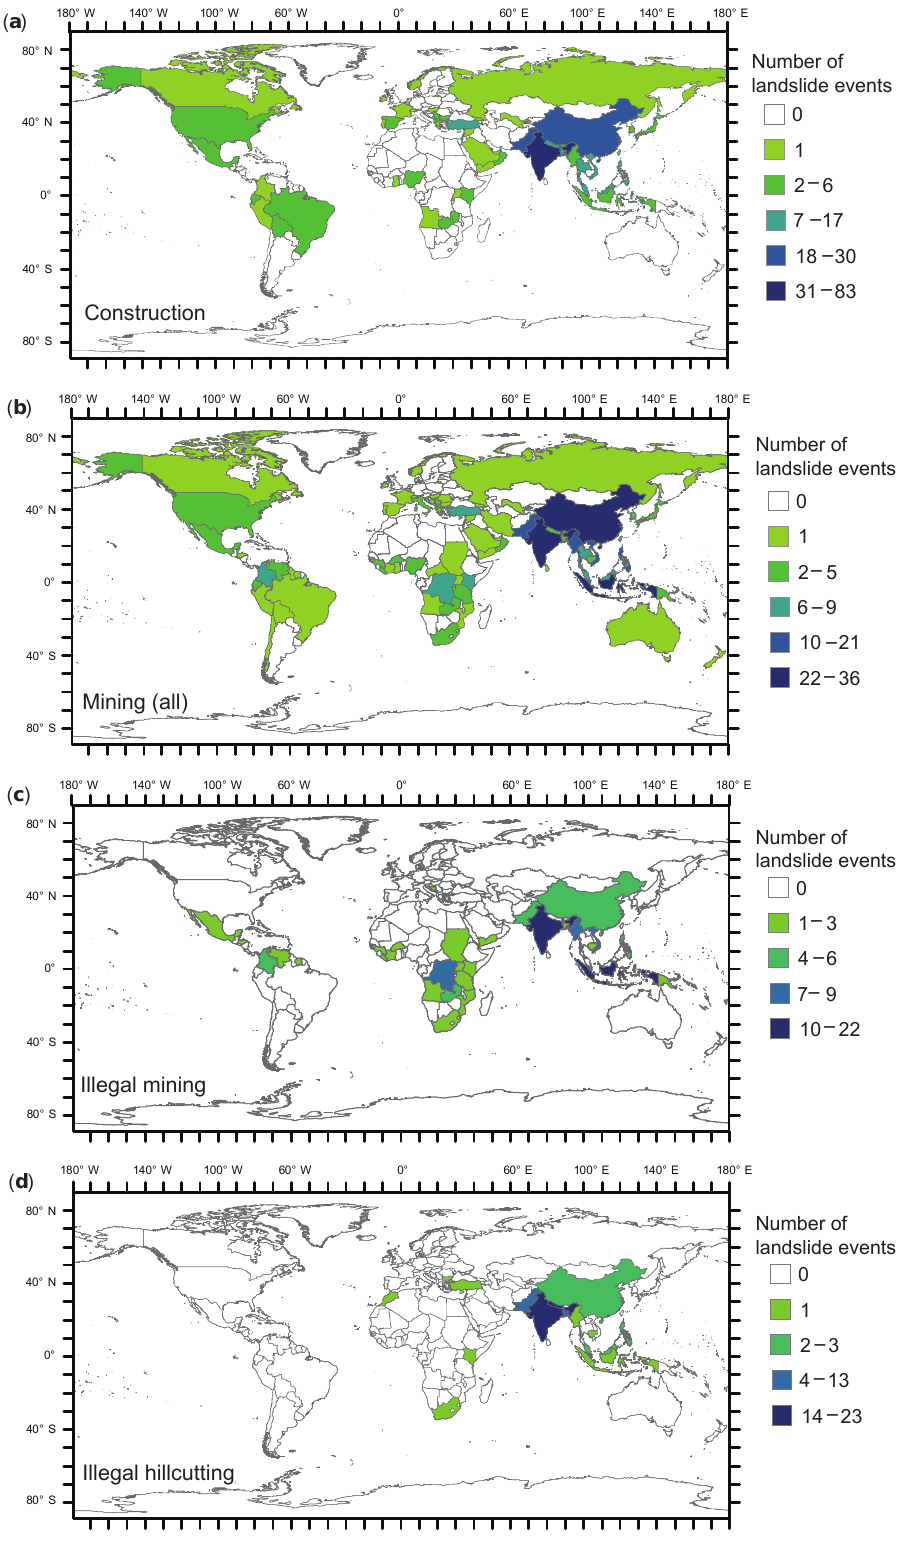
Figure 9. By country, the number of landslide events triggered by (a) construction, (b) mining, (c) illegal mining and (d) illegal hill cutting, between 2004 and